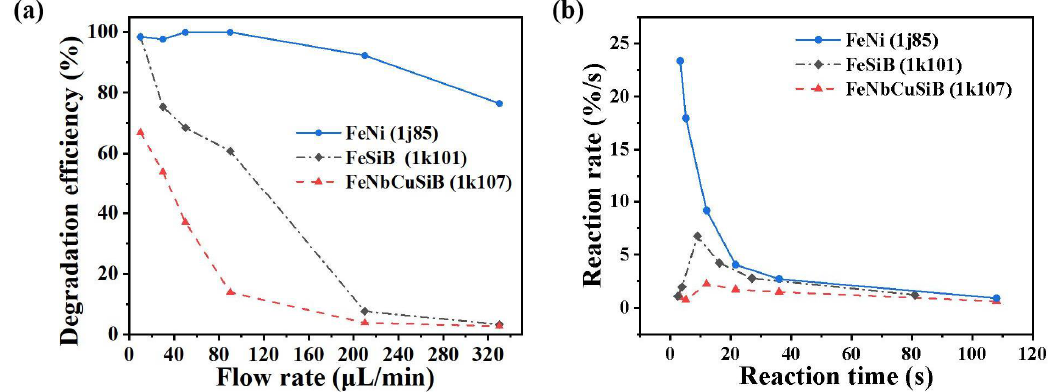
Figure 3. The MB degradation by using the microreactors with the different Fe-based sheets at dif- ferent flow rates; ( a ) the degradation efficiency; ( b ) the reaction rate as the function of the reaction